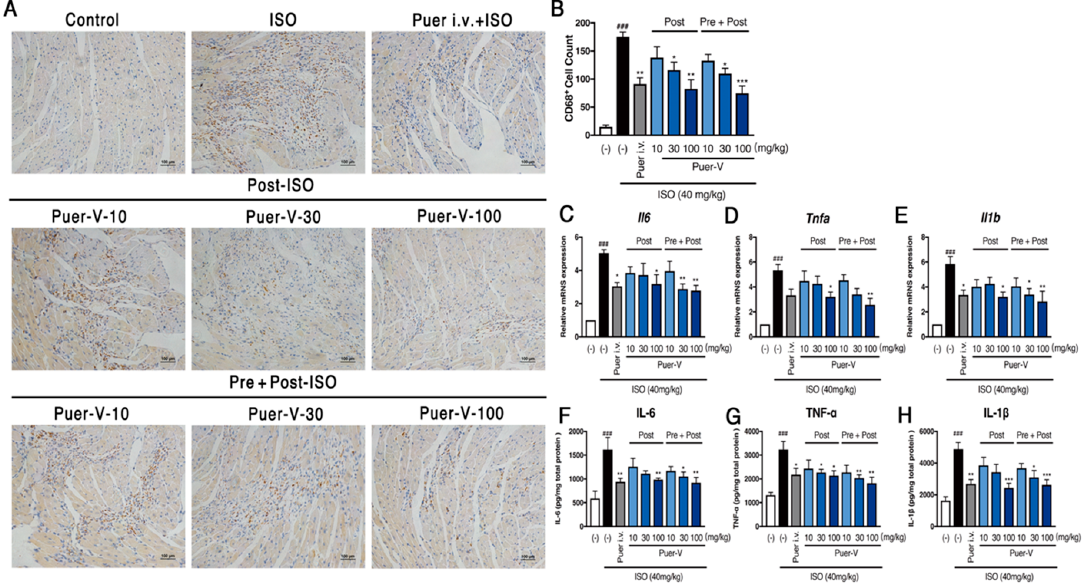
Figure 4. Puerarin-V reduced myocardial inflammation in the heart of MI mice. ( A ) Immunohistochemical analysis of macrophage marker CD68 in heart cross sections. The original magnification of the images was 200×. The scale bar is 100 μ m. ( B ) The percent of CD68 + cells ( n = 4). ( C – E ) The mRNA levels of IL-6, TNF- α , and IL-1 β ( n = 6). ( F – H ) The quantitative analyses of IL-6, TNF- α , and IL-1 β by ELISA ( n = 6). Data are shown as mean ± SEM. ### p < 0.001 vs control group. * p < 0.05, ** p < 0.01, and *** p < 0.001 vs model group.